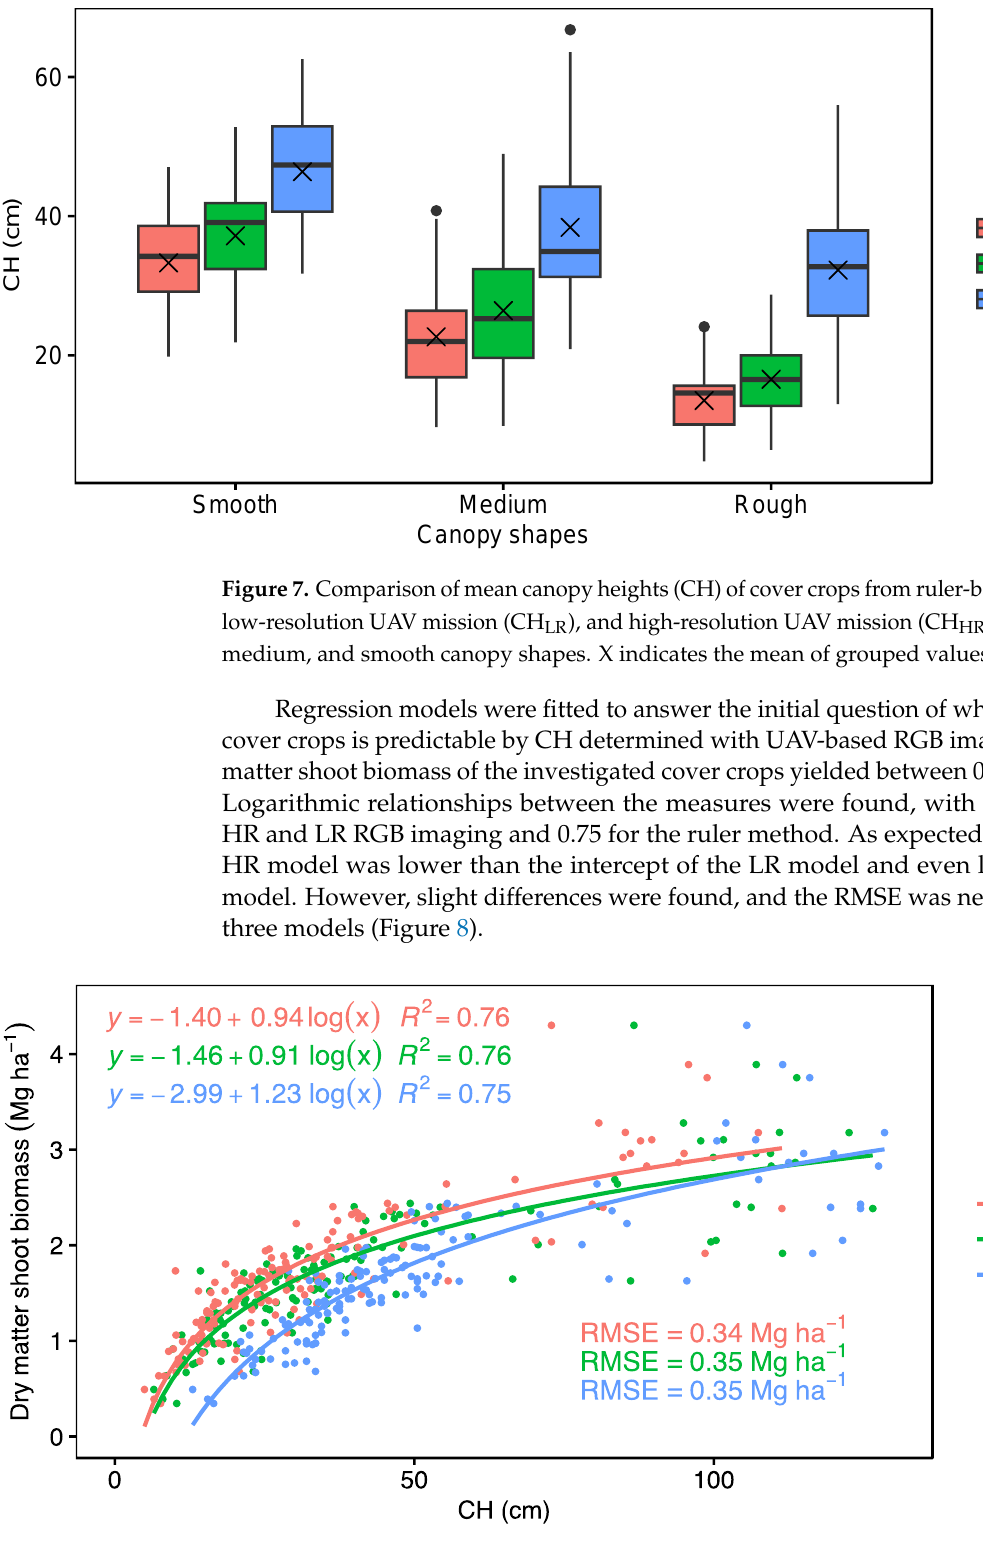
Figure 8. Regression models for dry matter shoot biomass of cover crops based on canopy height from UAV-based RGB-imaging (CH UAV ) with low resolution (CH_LR) and high resolution (CH_HR)